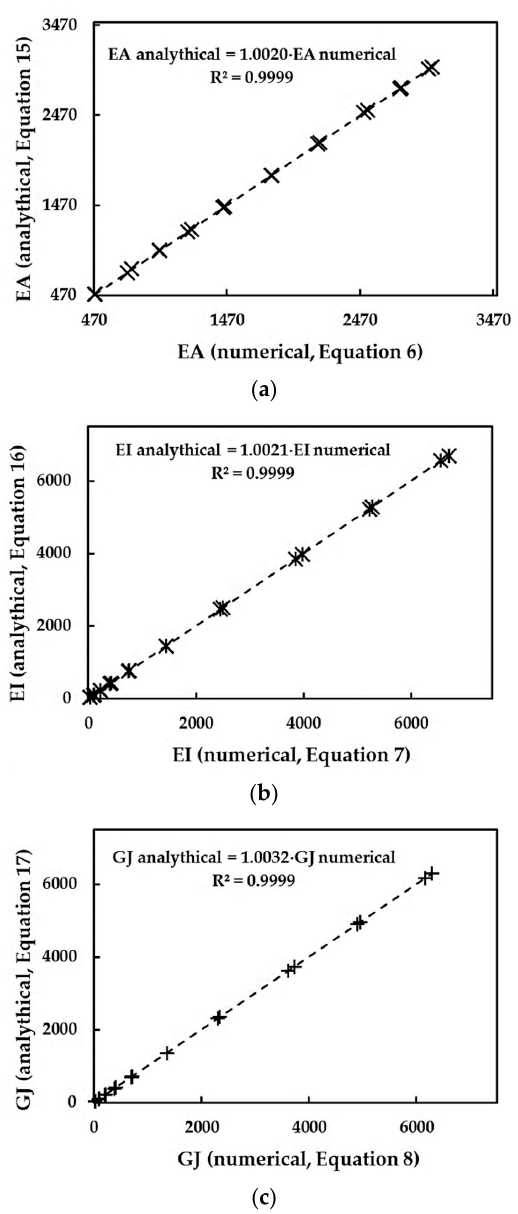
Figure 4. Comparison between the ( a ) tensile, EA, ( b ) bending, EI, and ( c ) torsional, GJ, rigidities, obtained from FE analyses with help of Equations (6)–(8), and those evaluated by analytical expressions (15)–(17).